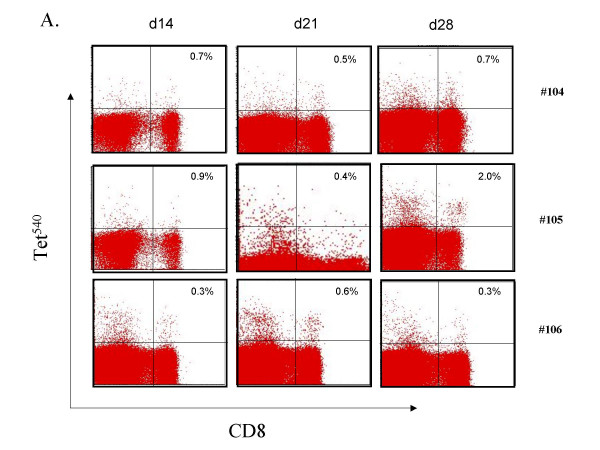
Detection of tet-positive CD8 T lymphocytes after single vaccination with transgenic B lymphocytes. (A). Ex vivo detection of tet540-positive CD8 T cell responses on day 14, 21 and 28 in vaccines of cohort 2 who received a single vaccine injection of 105transgenic B lymphocytes. (B) Example of expansion of tet540-positive CD8 T cell responses after in vitro peptide restimulation in patient 107 who received a single vaccine injection of 106transgenic B lymphocytes. R – restimulation in culture followed by the number of restimulations.